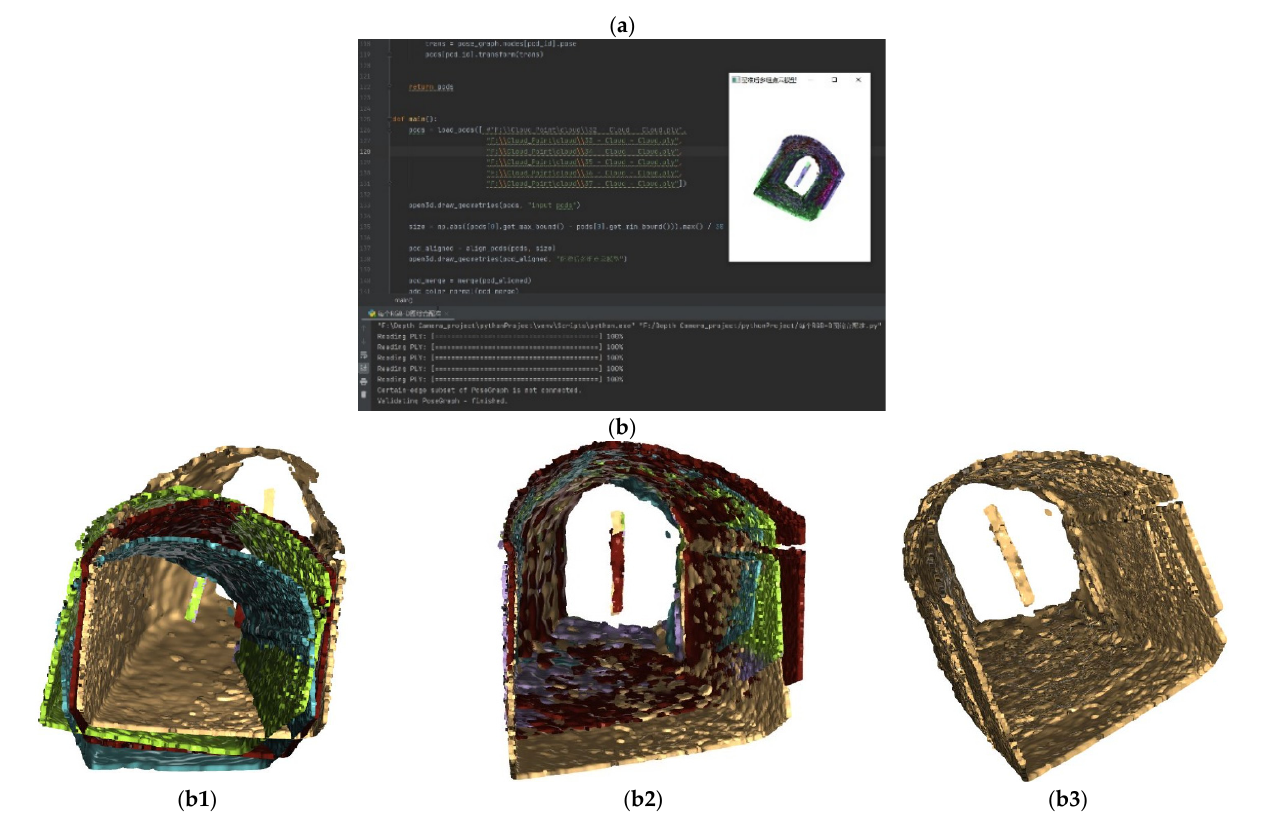
Figure 11. ( a ) Python point cloud data processing interface. ( b ) Process diagram of point cloud data registration of depth camera. ( b1 ) Before registration; ( b2 ) Registration in progress; ( b3 ) After registration.